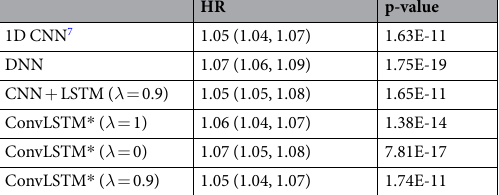
Table 3. Results of the Cox proportional hazard (Cox PH) model applied on the normalized biological age acceleration η = ( CA − BA )/ CA for estimated biological